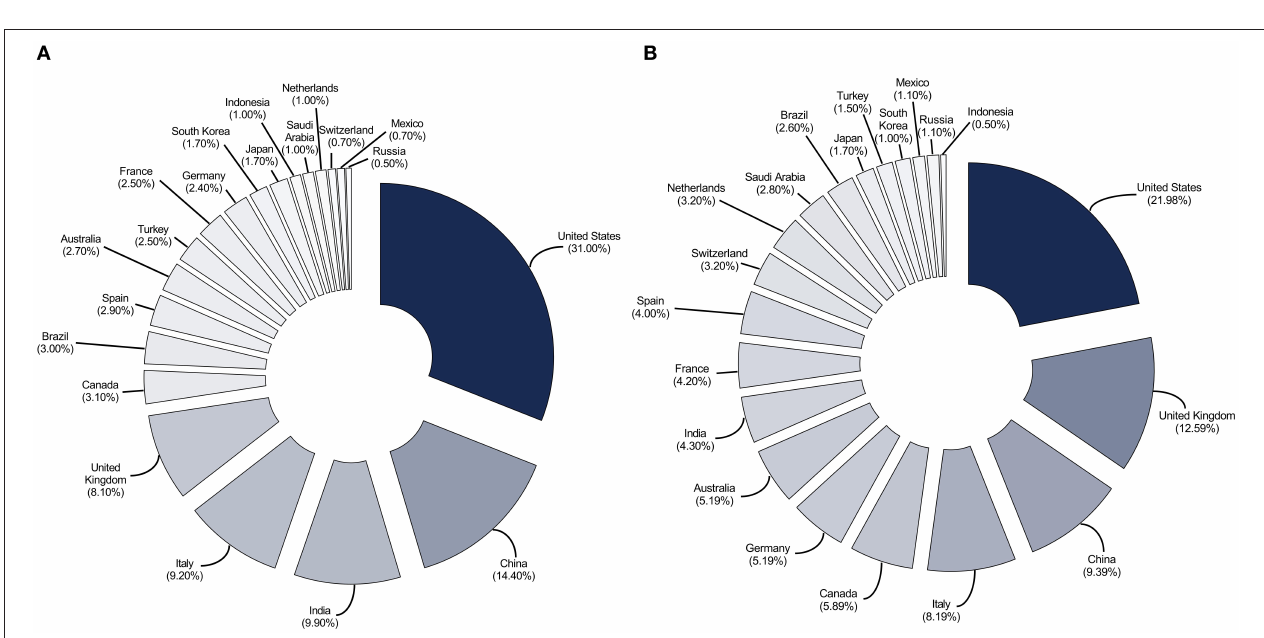
selected domains. China, India, Italy, and the United